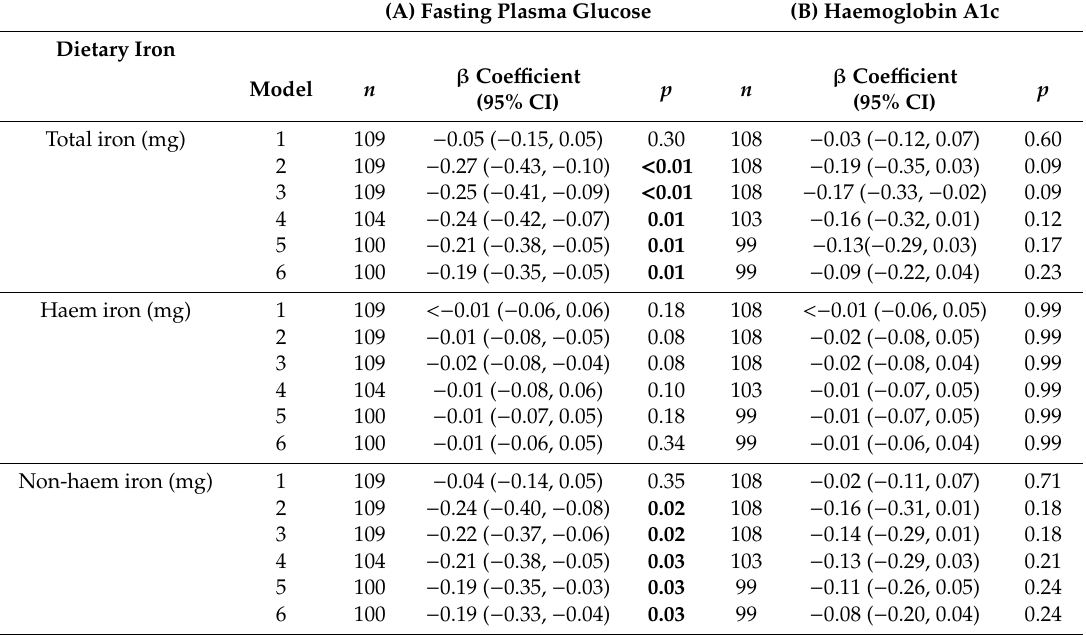
Table 2. Association between (A) fasting plasma glucose, (B) haemoglobin A1c and dietary iron in the overall